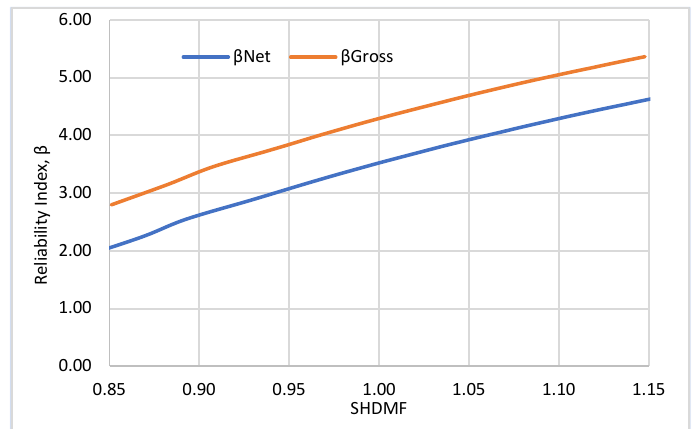
Figure 3. Beta reliability index β for net and gross